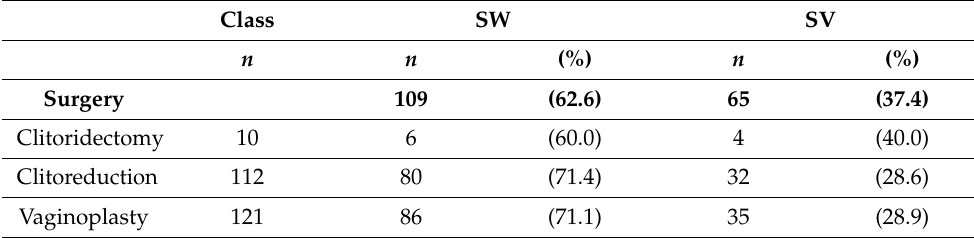
Table 2. Proportion of surgeries per CAH